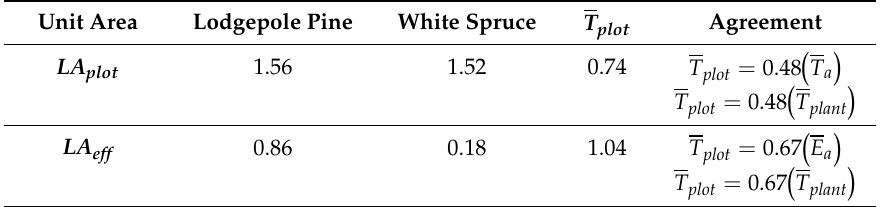
(cid:17) (cid:16) T a (cid:16) (cid:17) T plot = 0.48 T plant (cid:16) (cid:17) E a (cid:16) (cid:17) T plot = 0.67 T plant (cid:16) (cid:17) T plot = 0.64 E a (cid:16) (cid:17) T plot = 0.62 T plant